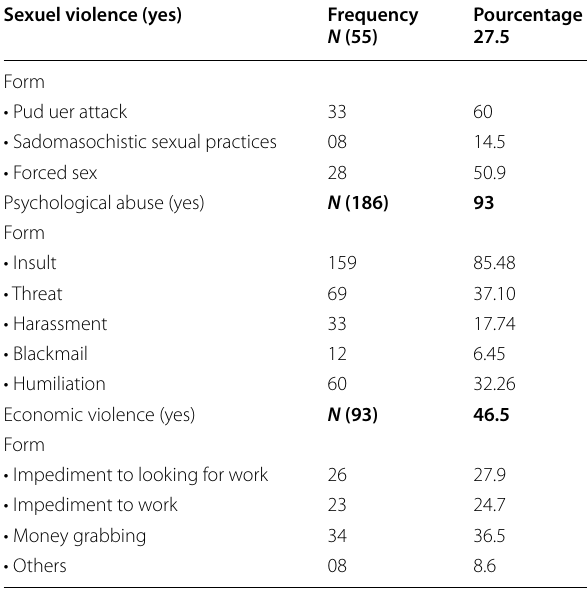
The three commonly known forms of interpersonal violence were present in our population, in order of frequency, respectively: psychological violence, economic violence, and sexual violence a A single victim can be subjected to several forms of violence.